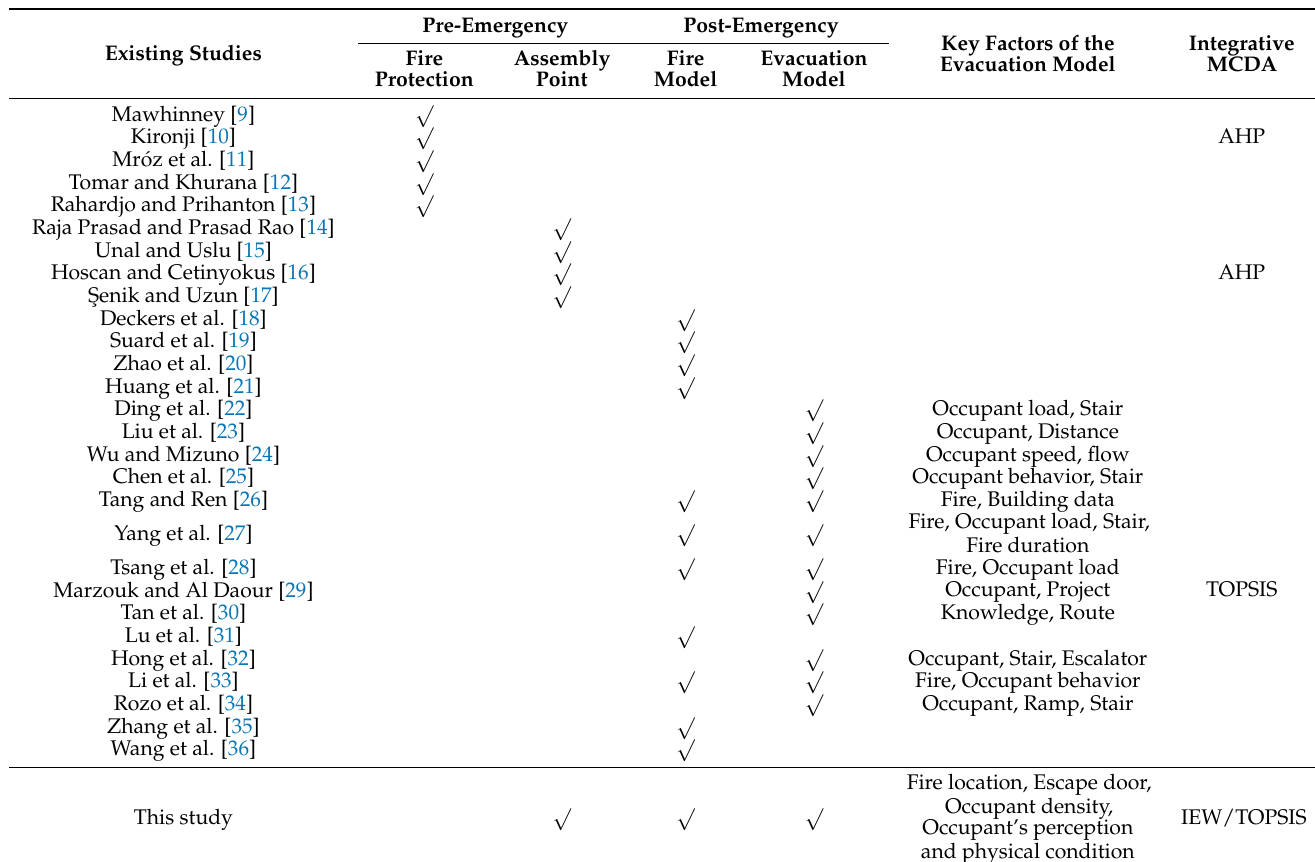
Table 1. Summary of literature